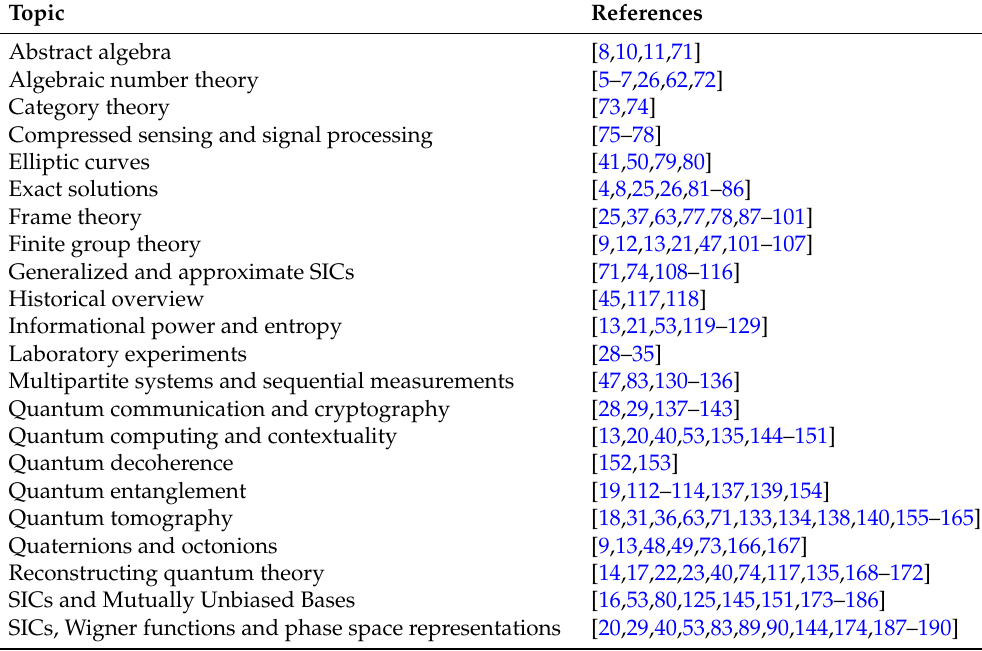
Table 1. References classified by the topics to which they give significant